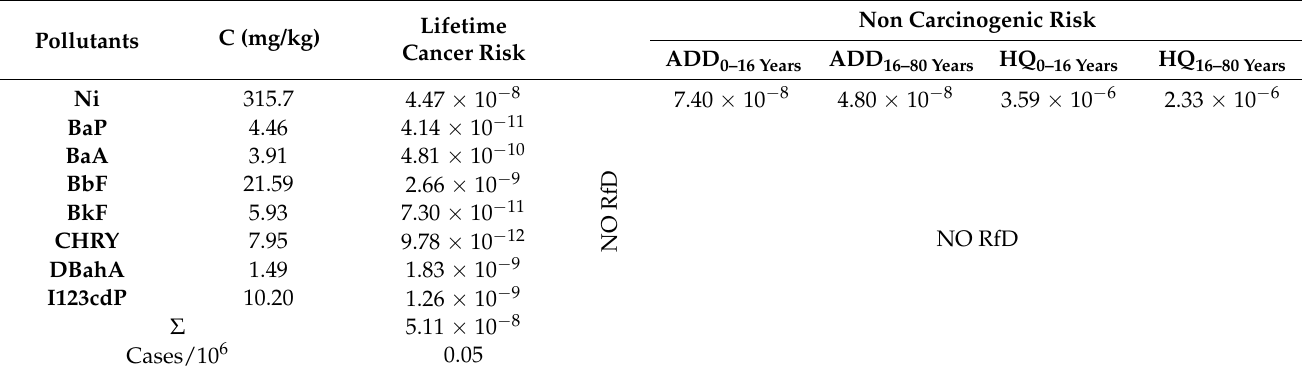
Table A7. Risk assessment B.II method (Tianjie, 2018).